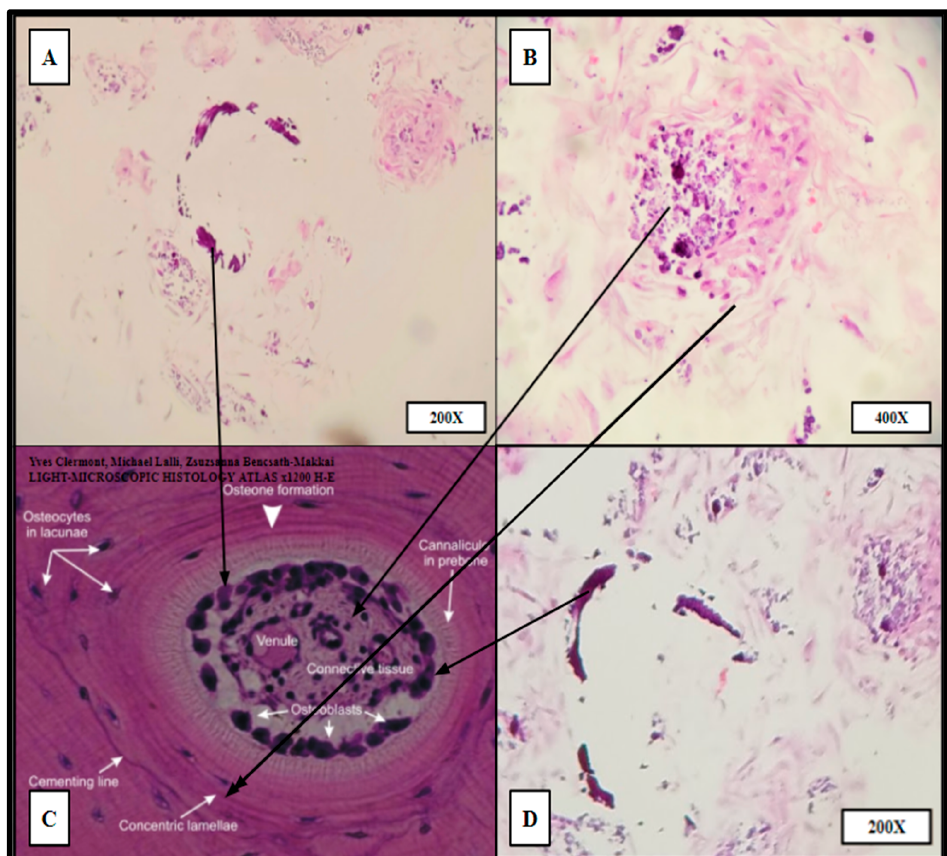
Figure 9. “Proto-osteon” cellular arrangement observed by routine H&E staining of HC infill pattern 3D printed PCL scaffolds seeded with primary hBM cells and cultured for 21 days in rotating shaker culture. Panels ( A , B , D ) display in vitro de novo histology resembling cellular arrangement and spe- cialization similar to native mature bone architecture (Panel ( C )). Partial rings of mineralization (dark purple crescents in A , D ) can be seen within the cultured scaffold as well as concentric organizations of stromal-like cells ( A , B , D ). Panels ( B , D ) were imaged from HC infill PCL scaffold seeded with BM008. Panel ( A ) was imaged from HC infill PCL scaffold seeded with BM009.